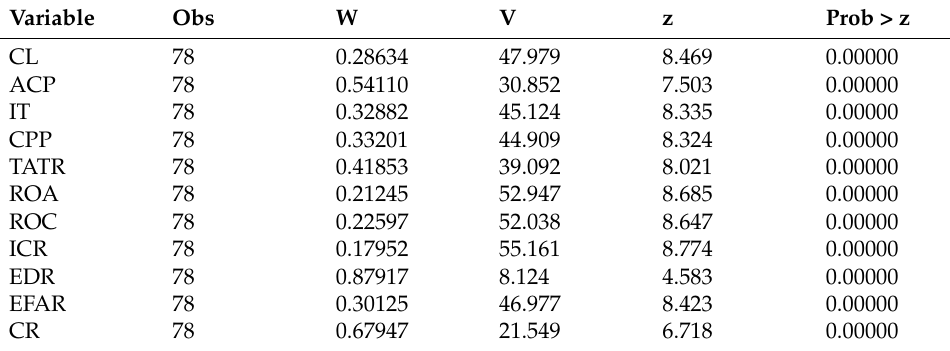
Table A3. Results of Shapiro–Wilk test—non − prosperous